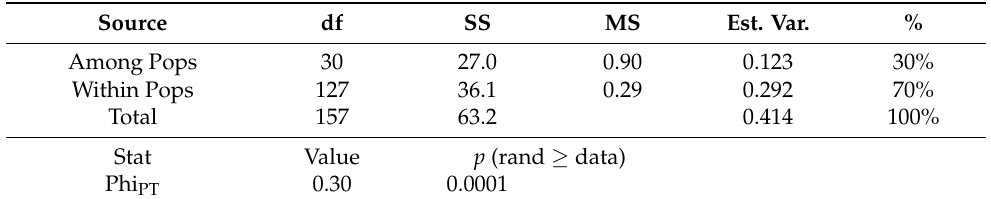
Table 5. The results of AMOVA on cpSSR alleles. The p -value of the differentiation index was based on 9999